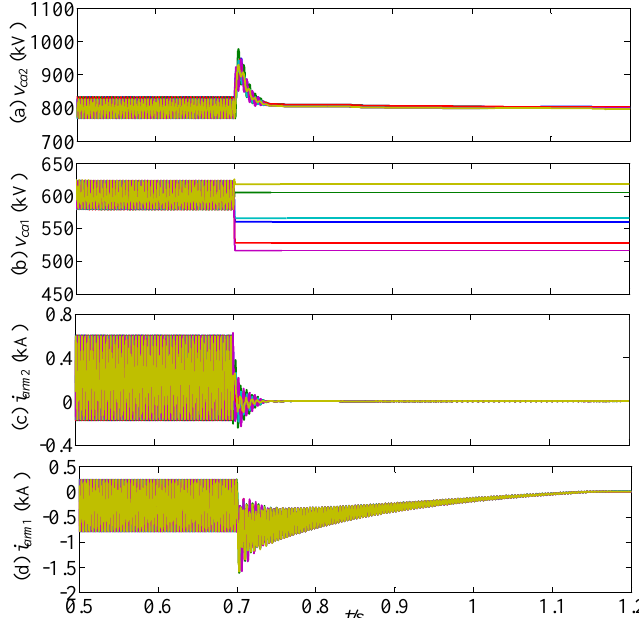
Figure 4. Other waveforms in the proposed standby operation of the DC/DC converter during a fault on Cable 3 at t 0 = 0.7 s: ( a ) sum of the SM capacitor voltages per arm of MMC 2 ; ( b ) the sum of the SM capacitor voltages per arm of MMC 1 ; ( c ) arm currents of MMC 2 ; and ( d ) arm currents of MMC 1 .